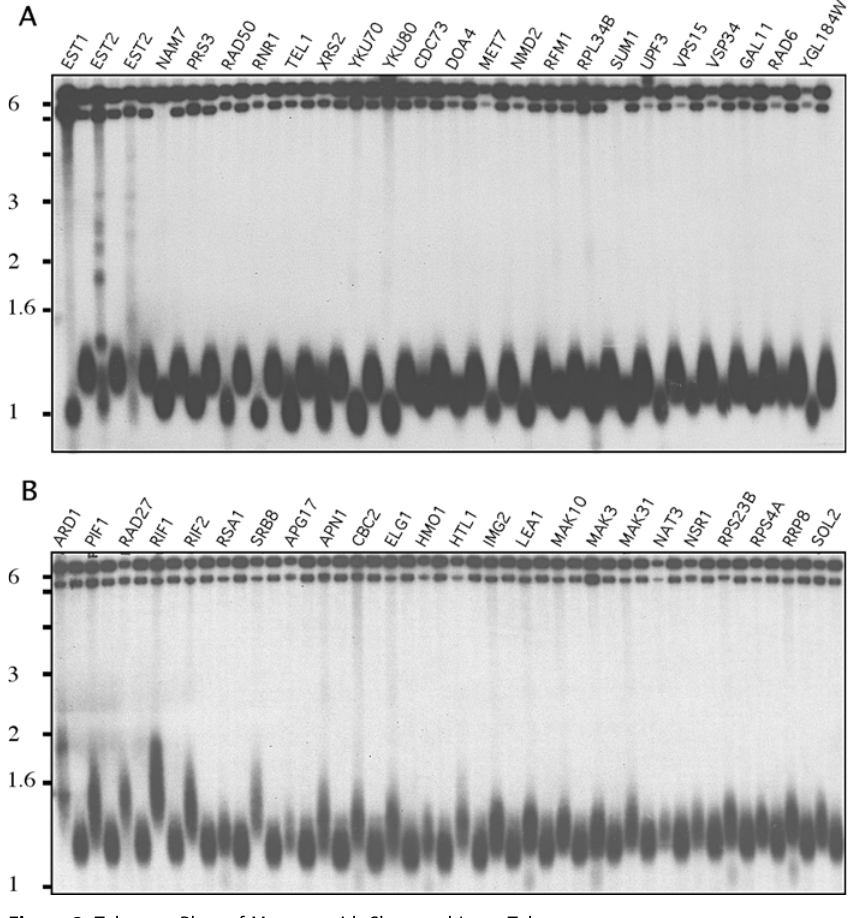
Figure 2. Telomere Blots of Mutants with Short and Long Telomeres Short (A) and long (B) telomeres. Every other lane (unlabeled) presents DNA isolated from wild-type cells. DOI: